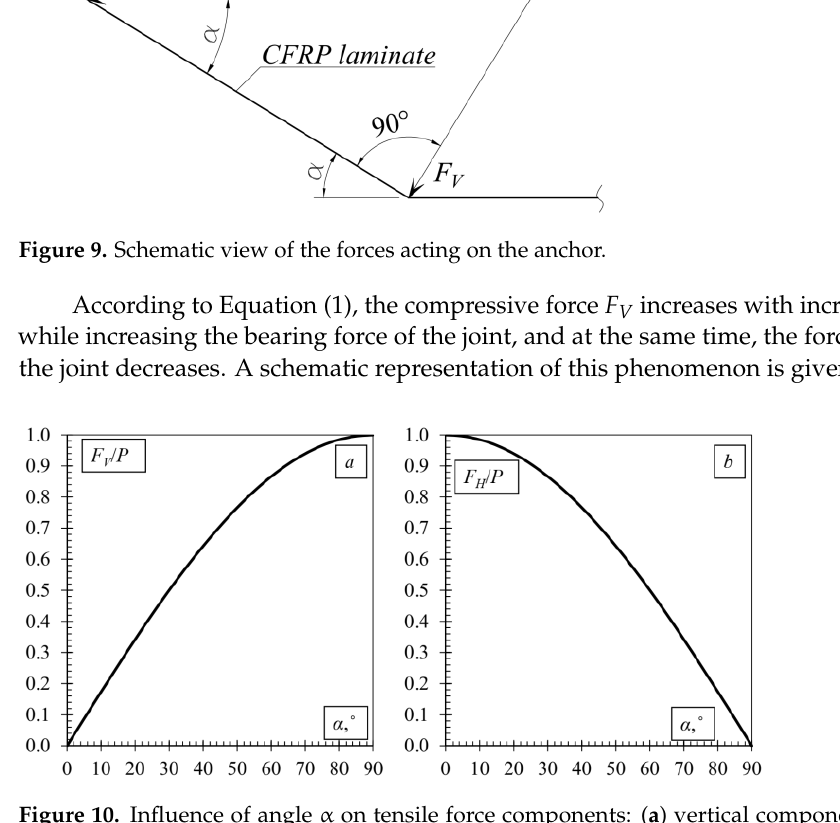
Figure 10. Influence of angle α on tensile force components: ( a ) vertical component; ( b ) horizontal component.